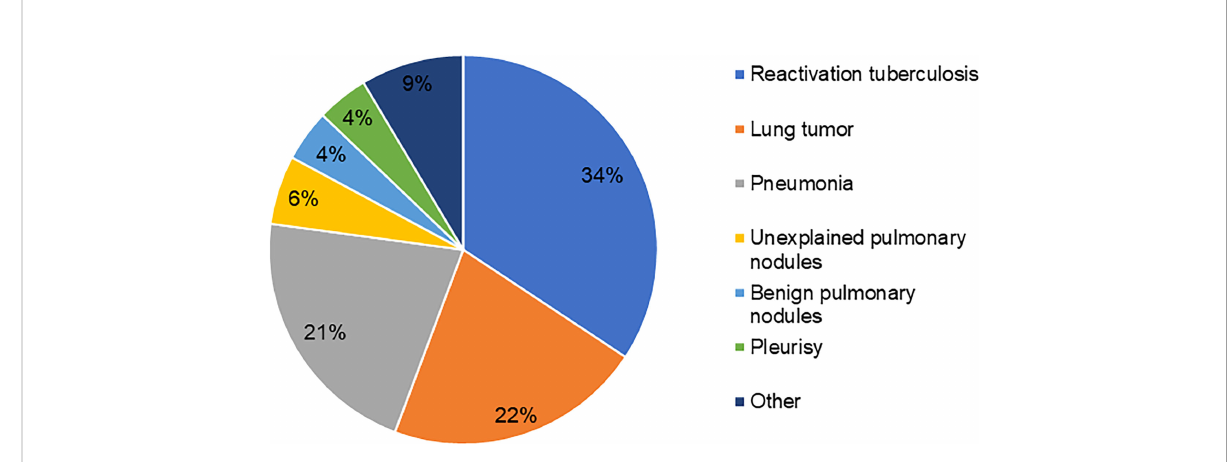
FIGURE 4 Diagnostic distribution of T. whipplei positive patients in BALF.